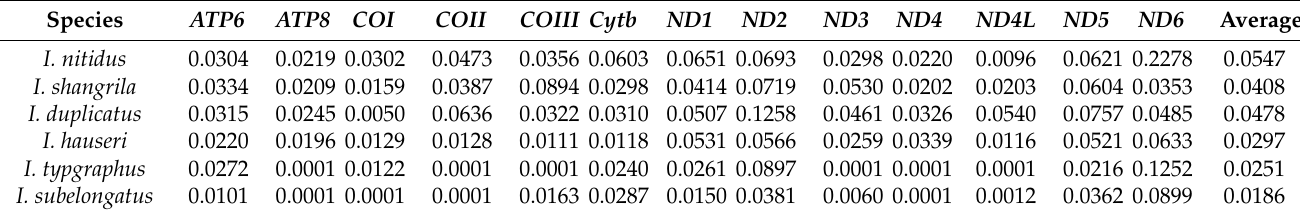
Figure 4. Sampling locations of Ips bark beetles. A simplified maximum likelihood tree (ML) based on mtDNA is shown at the top of the figure. The inset in the lower right shows the best genetic clustering (K = 6–10) based on SNP. Table 2. Ka/Ks values for each mitochondrial protein-coding gene of six species.